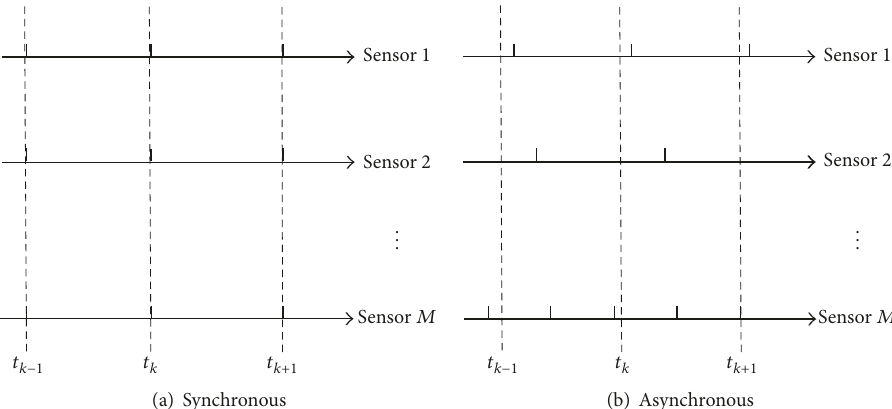
Figure 1: Observations from multiple